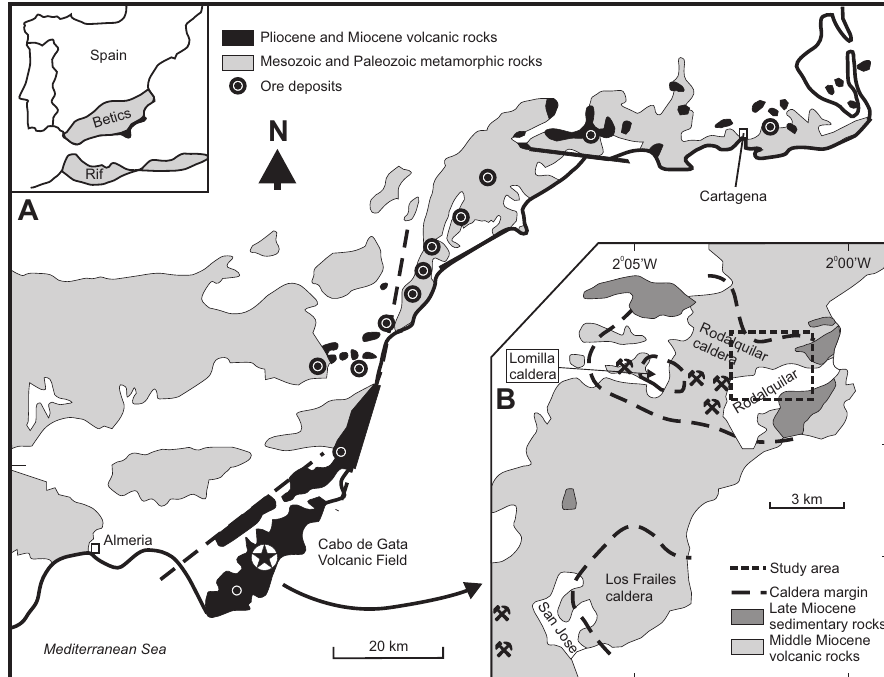
Figure 2. Location of the former mining town of Rodalquilar in the volcanic belt of southeast Spain (inset ( A )) and the location of the image dataset used in this study (inset ( B )). The Cabo de Gata volcanic field consists of calc-alkaline volcanic rocks (andesites and rhyolites) of late Tertiary age which have been extensively altered to form an assemblage of metamorphic minerals from high to low temperature as: silica, alunite, kaolinite, montmorillonite and chlorite. The geology, geochemistry and mineralization of the area is documented [35], while several remote sensing studies have been conducted at this site [36–39]. Image modified after Arribas et al. [35] and Rytuba et al. [32] and used with permission from Van der Meer et al.